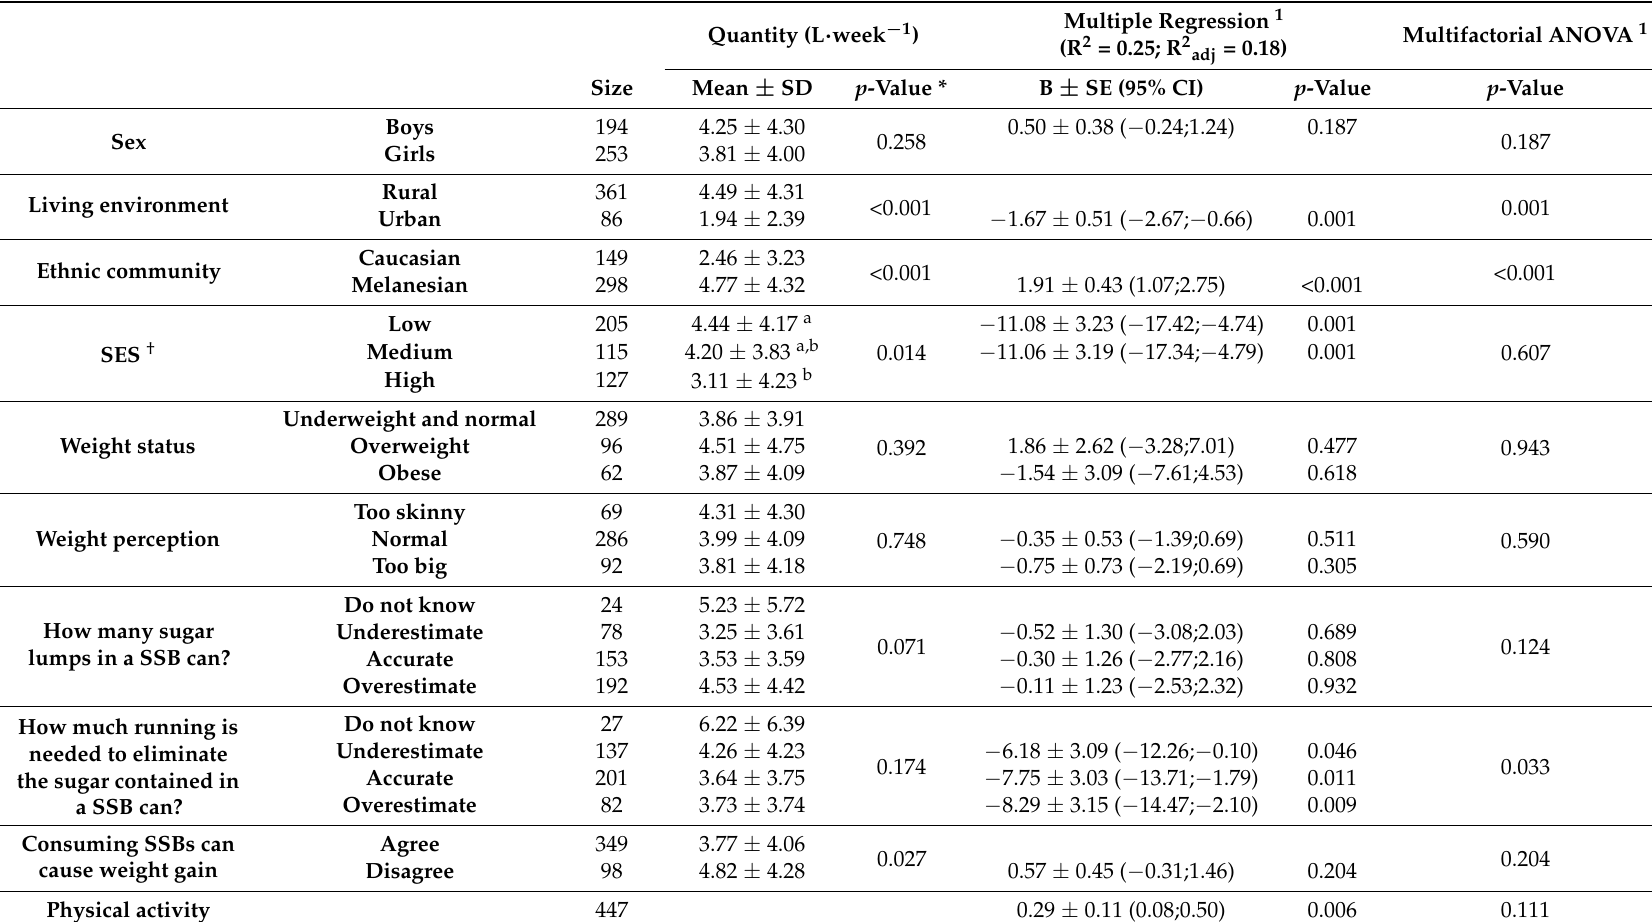
Table 2. SSB consumption: quantity, multifactorial regression and ANOVA ( n =